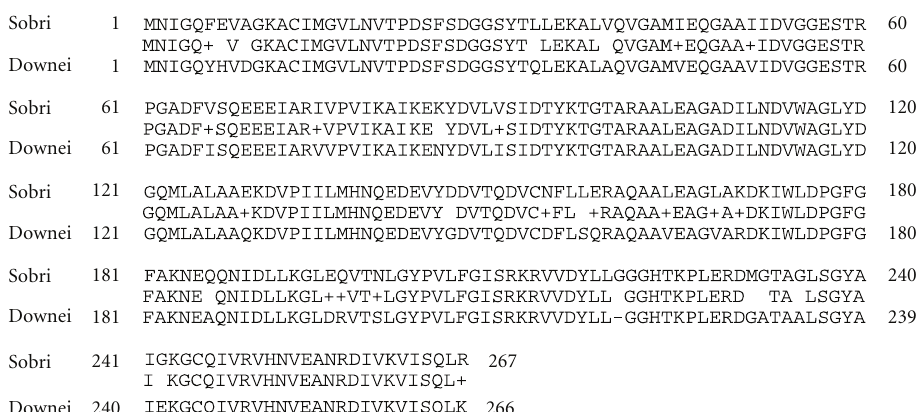
However, during cultivation, we obtained S. sobrinus strains with varying degrees of sulfa and tp susceptibilities, but no changes were noted in this